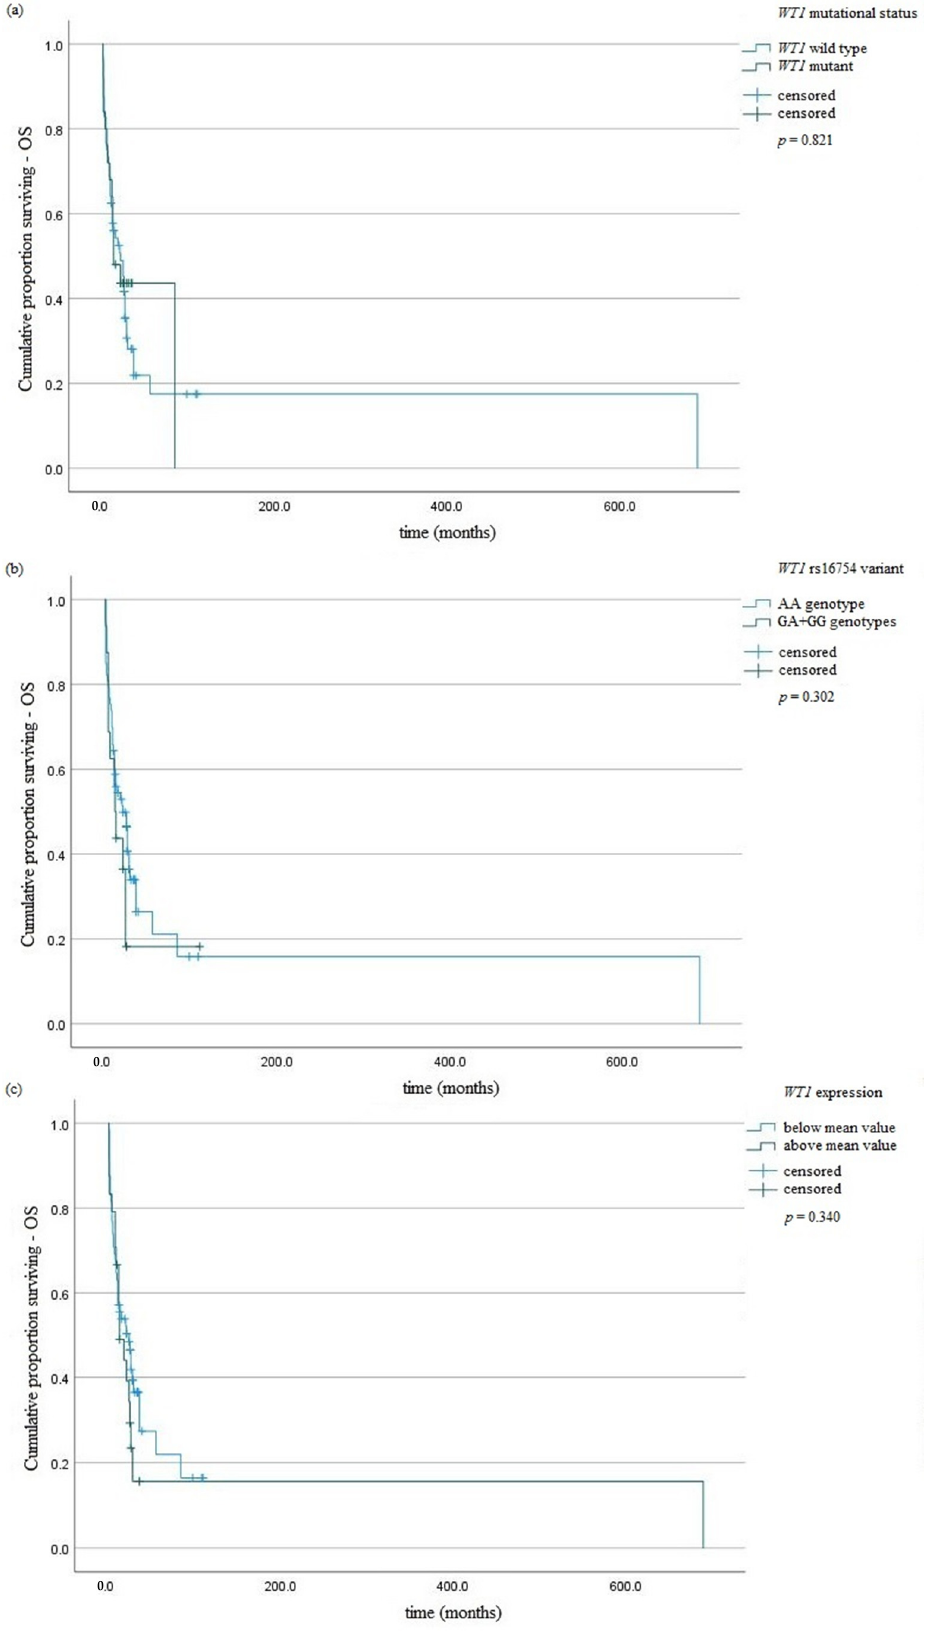
Figure 1. Kaplan–Meier analysis of OS in the group of AML patients taking into account: ( a ) WT1 mutation; ( b ) WT1 rs16754 variant; ( c ) WT1 overexpression.